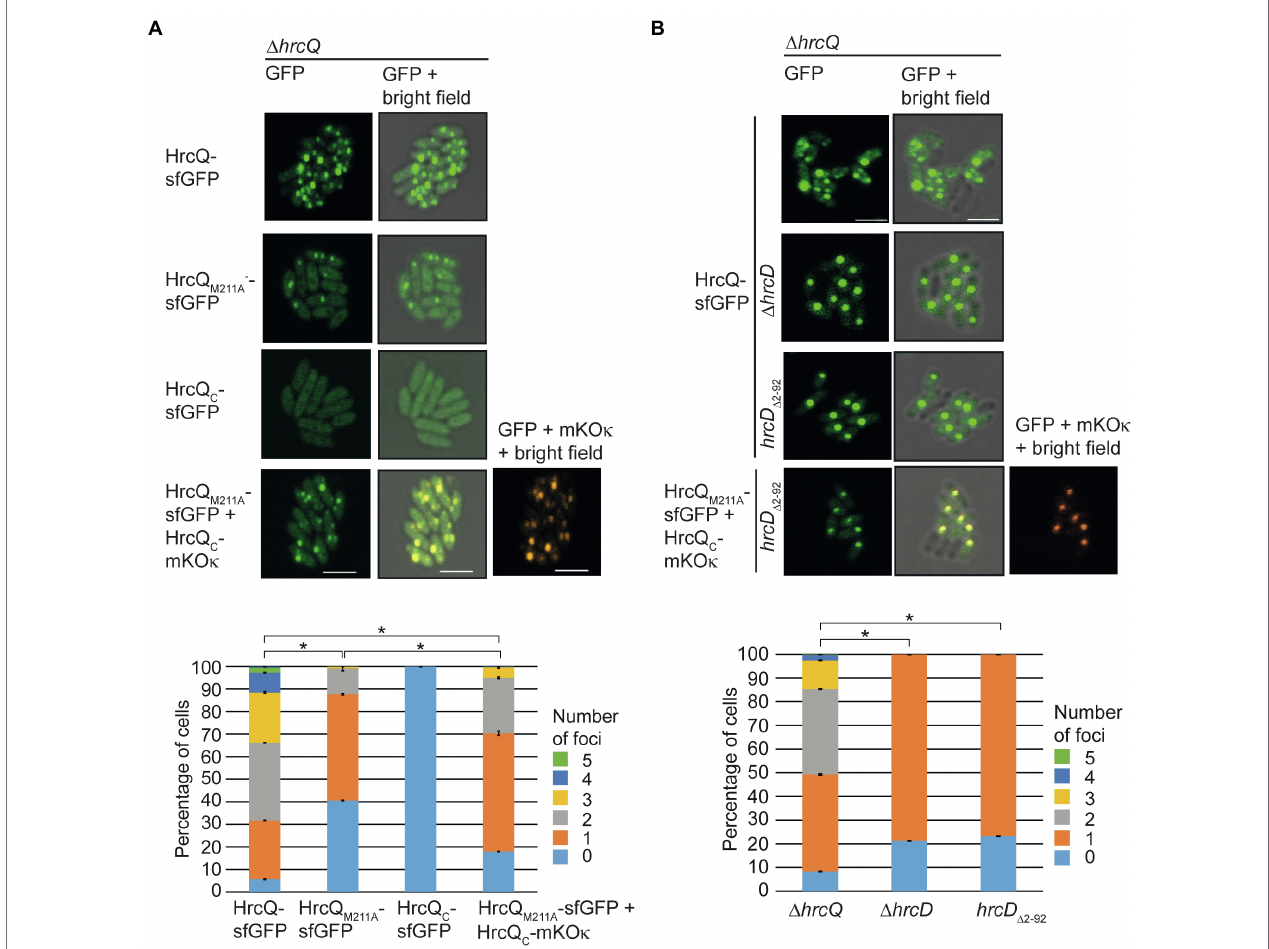
FIGURE 8 | Fluorescent fusions of HrcQ and HrcQ C colocalize independently of their association with the T3S system. (A) Colocalization of sfGFP fusions of HrcQ M211A and HrcQ C . Xanthomonas campestris pv. vesicatoria strain 85* ∆ hrp_ fs HAGX with plasmids containing the modular T3S gene cluster, accessory, and regulatory genes with a deletion in the native hrcQ gene ( ∆ hrcQ ) and encoding HrcQ-sfGFP, HrcQ M211A -sfGFP, HrcQ C -sfGFP, or a combination of HrcQ C -sfGFP and HrcQ C -mKO κ as indicated were incubated under T3S-permissive conditions and analyzed by fluorescent microscopy. One representative image for every strain is shown. The size bar corresponds to 2 μ m. The pictures in the right panels result from an overlay of the signals from the fluorescent channel for GFP and/or mKO κ with the bright field images. Fluorescent foci were counted in approximately 300 cells per strain in three transconjugants. Asterisks indicate a significant difference between the number of foci in strains with a p < 0.05 based on the results of a chi-squared test. Experiments were performed three times with similar results with different transconjugants for each strain. The results from one representative experiment are shown. (B) Fluorescent fusions of HrcQ M211A and HrcQ C colocalize in the bacterial cytoplasm. Strain 85* ∆ hrp_ fs HAGX with plasmids containing the modular T3S gene cluster, accessory, and regulatory genes with a deletion in the native hrcQ gene ( ∆ hrcQ ), additional deletions in hrcD ( ∆ hrcD ), or codons 2–92 of hrcD ( hrcD ) and encoding HrcQ fusion proteins as indicated was grown in secretion medium. The formation of fluorescent foci was analyzed as described in (A) . Experiments were performed three times with similar